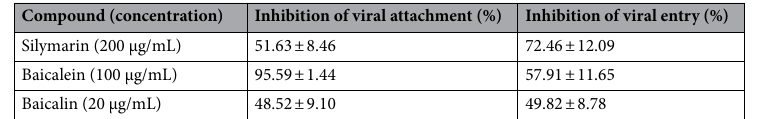
Table 5. Inhibition of DENV-3 viral attachment and entry by silymarin, baicalein, and baicalin. Data were acquired from three independent experiments and presented as mean ± standard error mean (SEM).